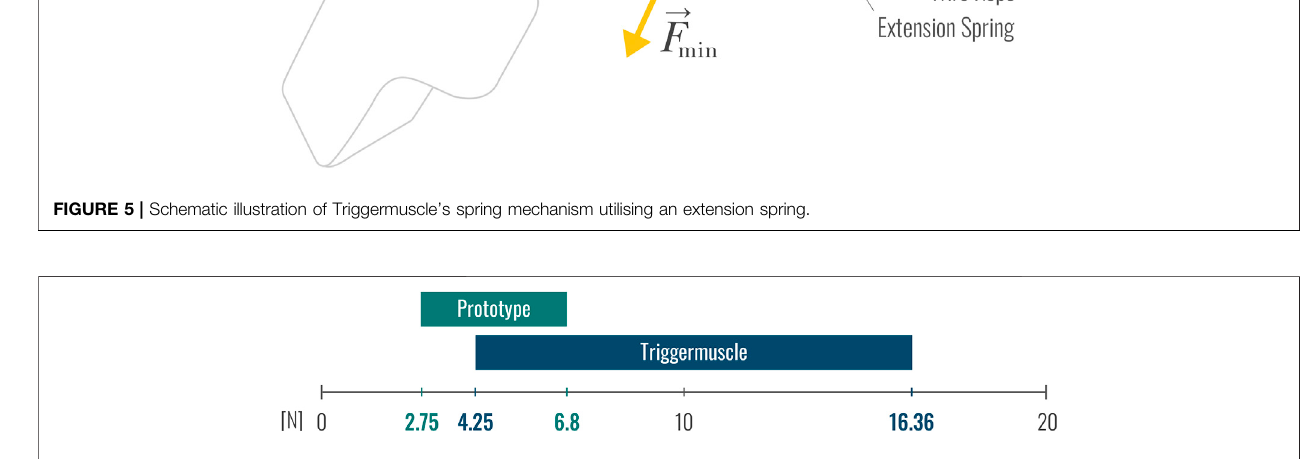
FIGURE 6 | Both ranges of trigger resistance of the prototype and Triggermuscle. The torsion spring ’ s torque values [Nmm] of the prototype were converted into [N] for the purpose of comparability.